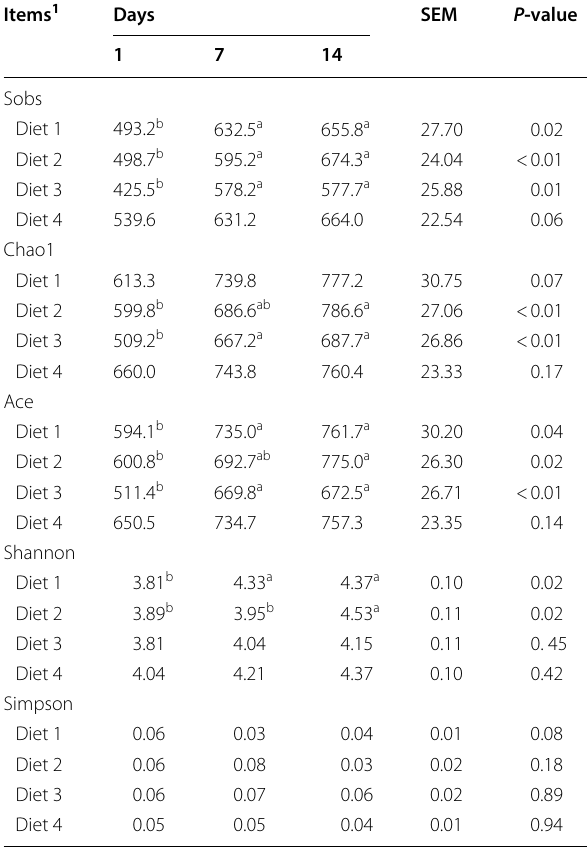
diversity indices of fecal bacterial communities in weaned piglets at different